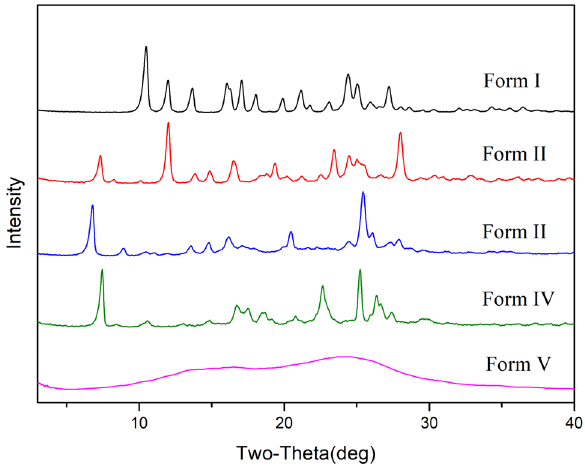
Fig. 10 PXRD patterns of mangiferin